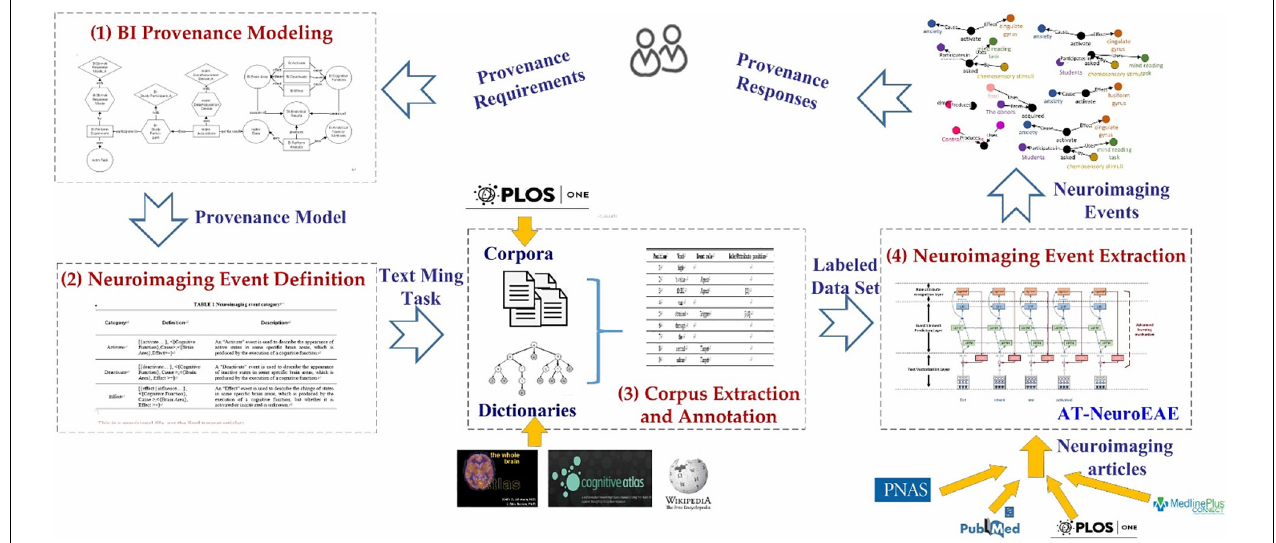
FIGURE 1 | The whole process of provenance information extraction. (1) Brain informatics provenance modeling: construct an improved BI provenance model to capture the provenance requirements of research sharing in open and FAIR neuroscience. (2) Neuroimaging event definition: define a group of neuroimaging events to transform the BI provenance model into text mining tasks. (3) Corpus extraction and annotation: construct a group of labeled corpora for model training and test. (4) Neuroimaging event extraction: develop the NeuroEAE model to extract defined neuroimaging events for meeting the provenance requirements in open and FAIR neuroscience.